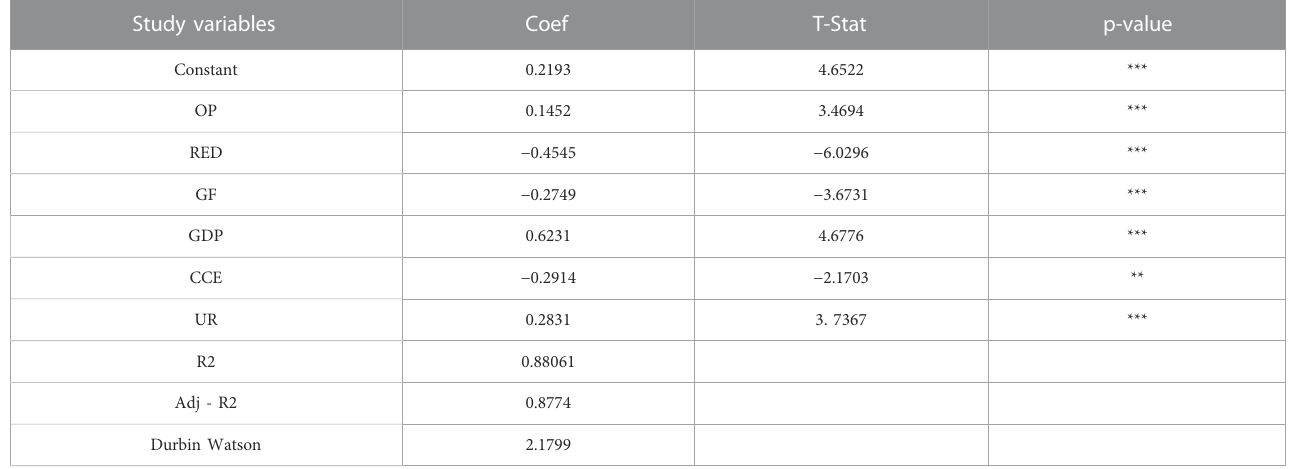
TABLE 7 Results of Long-run estimations of